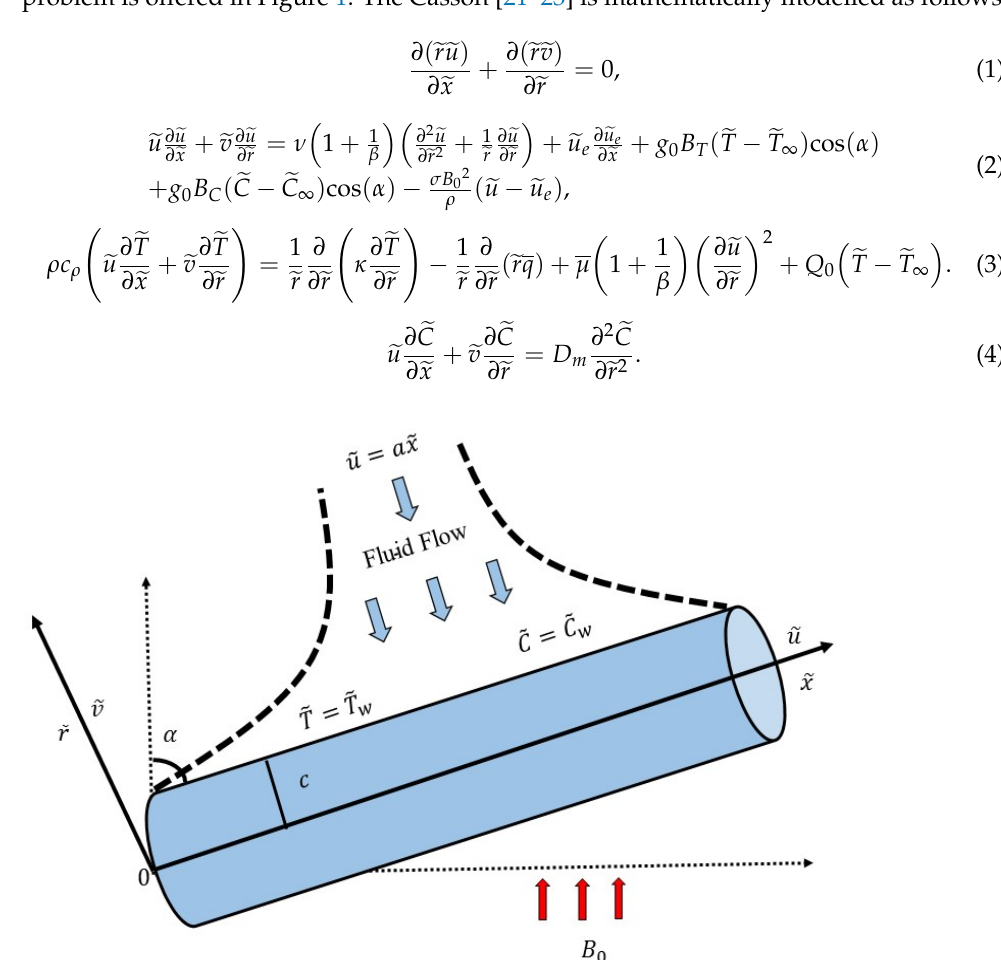
Figure 1. Geometry of the problem.